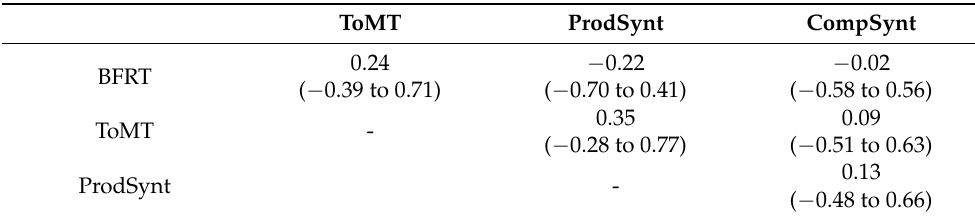
Table 4. Correlations for the DS group between Benton Facial Recognition Test (BFRT), Theory of Mind Test Revised (ToMT), ‘Production Syntaxique’ subtest (ProdSynt), and ‘Compr é hension Syntaxique’ subtest (CompSynt) and the 95 % confidence